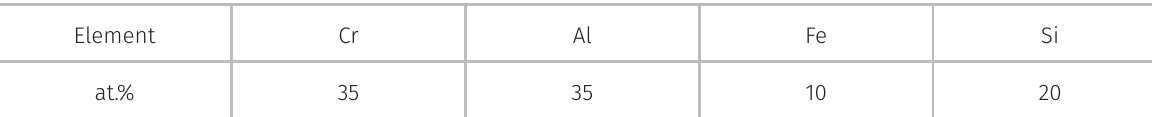
Table I. Chemical composition of the milled powder for the second step coating. Element Cr Al Fe Si